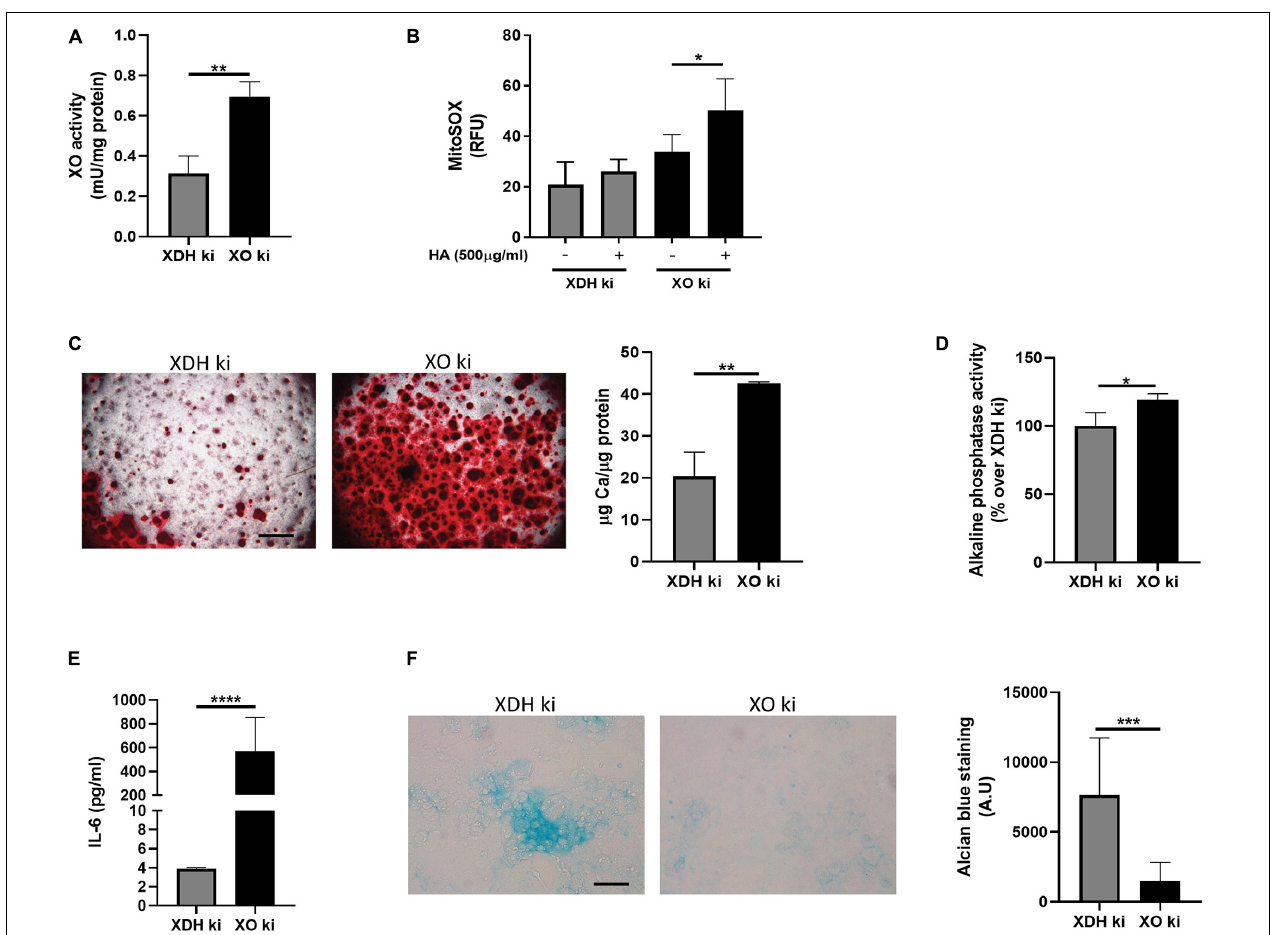
FIGURE 3 | Xanthine oxidase form of XOR is preferentially involved in chondrocyte mineralization, ROS production and IL-6 secretion. (A) XO activity measurement by AmplexRed Kit in cell homogenates from XDH ki and XO ki chondrocytes. ∗∗ p < 0.01. (B) Mitochondrial ROS production in XDH ki and XO ki chondrocytes stimulated or not with 500 µ g/ml HA crystals for 2 h. ∗ p < 0.05. (C) Representative Alizarin red staining of XDH ki and XO ki chondrocytes cultured with CPP for 24 h. Pictures from one experiment of three independent experiments are shown. Scale bar 400 µ M. Graphs represent calcium content in the cell monolayer of XDH ki and XO ki chondrocytes cultured with CPP for 24 h, expressed as µ g Ca/ µ g protein. ∗∗ p < 0.01. (D) Alkaline phosphatase activity measurement in cell homogenates from XDH ki and XO ki chondrocytes cultured with CPP for 6 h. ∗ p < 0.05. (E) IL-6 secretion in cell supernatant of chondrocytes from point (c). ∗∗∗∗ p < 0.0001. (F) Representative Alcian blue staining of XDH ki and XO ki chondrocytes cultured for 10 days. Pictures represent triplicates from one experiment of two independent experiments. Scale bars 100 µ M. Graphs represent quantification of Alcian blue staining in the cell monolayer. ∗∗∗ p < 0.001.